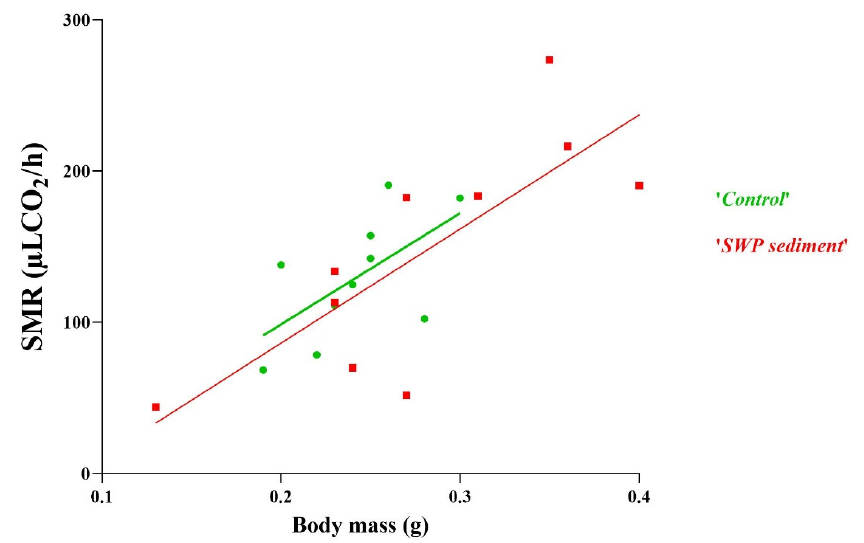
Figure 4. Standard metabolic rate (SMR) of 20 green toad toadlets (Gosner 46) in relation to body mass, in green the individuals of the control condition and in red the individuals exposed to sediment from SWP. Metabolic rate did not di ff er between exposure conditions (F = 0.36, d = 1, p = 0.56).